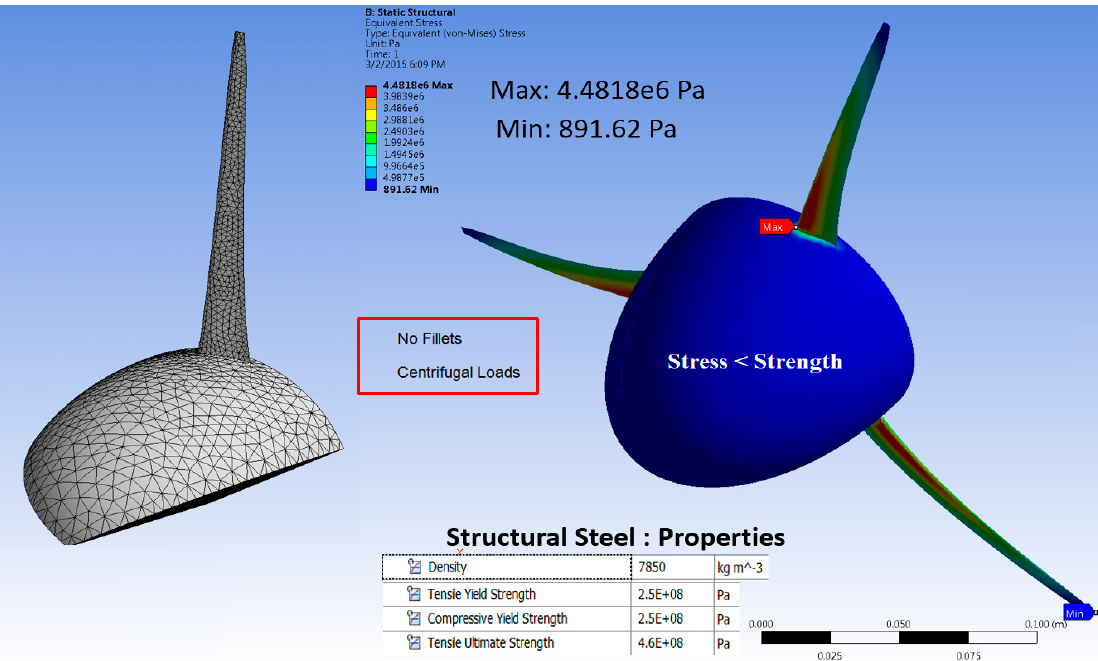
Figure 35. Centrifugal stress analysis on 4 kW HKT without fillets.